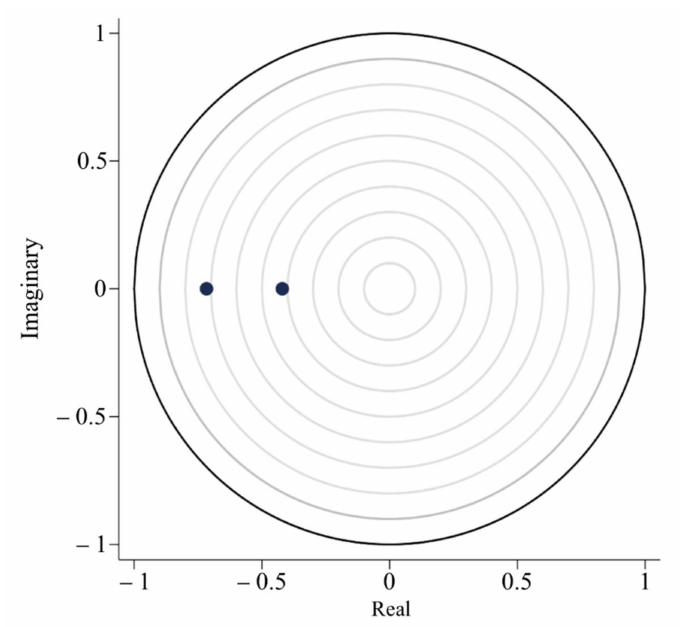
Figure 9. Reciprocal value of the root module of the PVAR model.